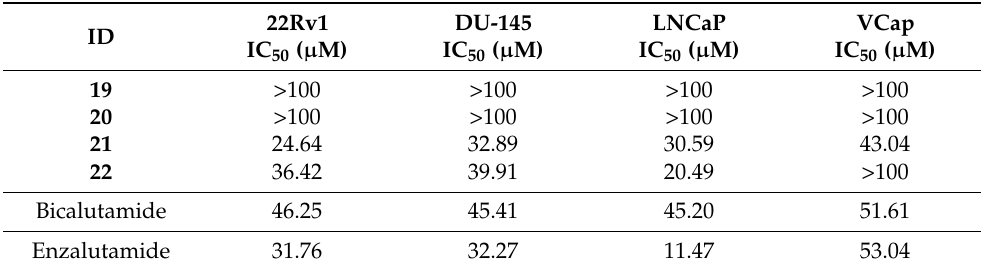
carried out on three separate